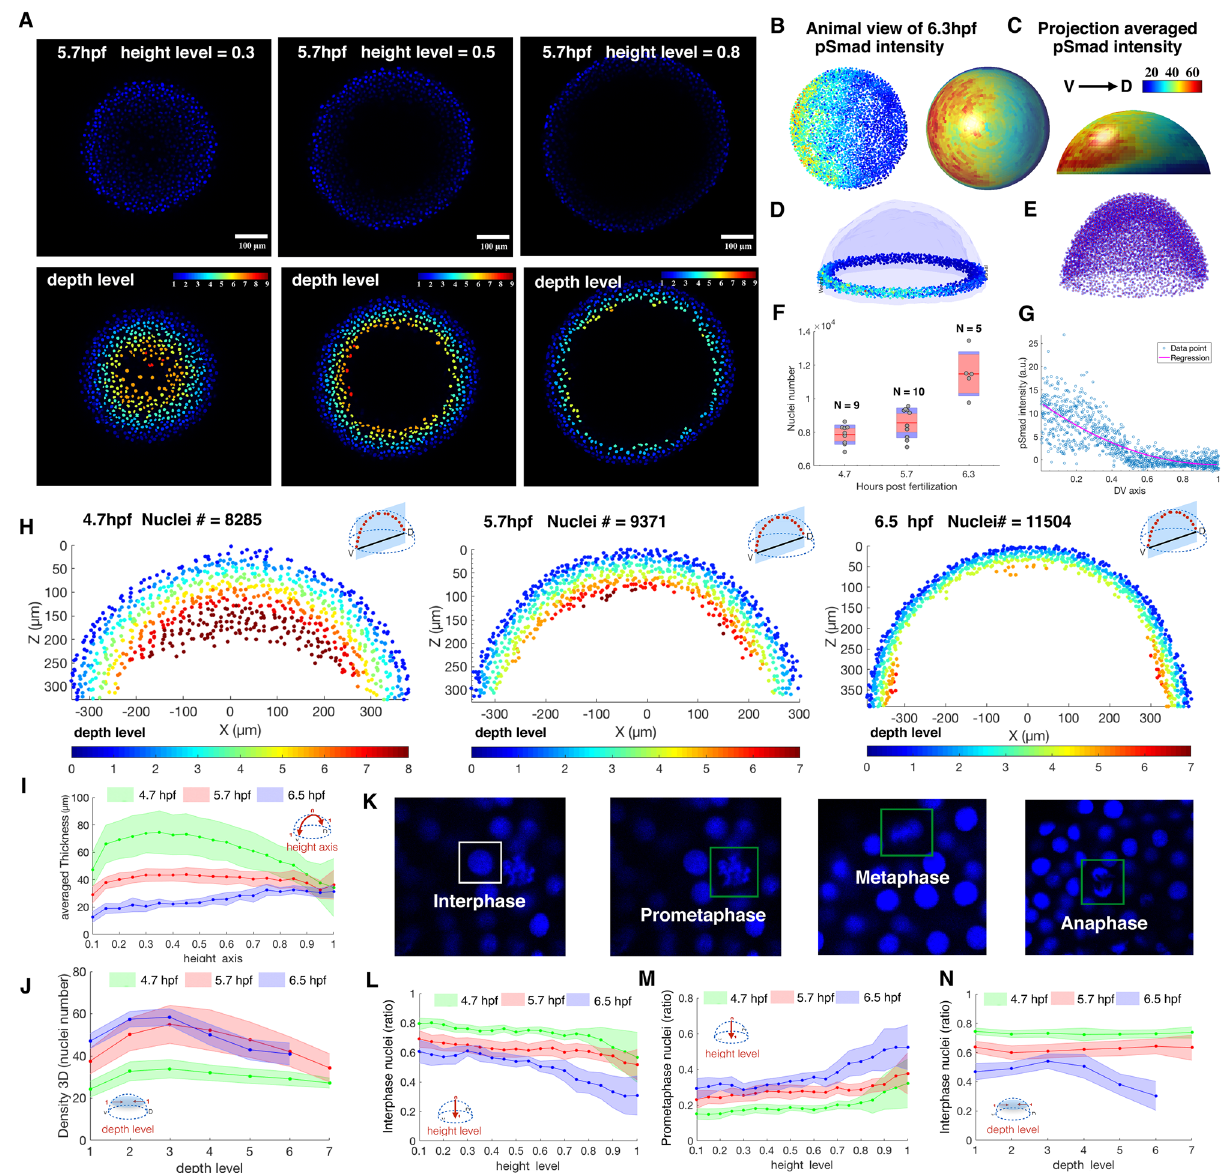
Figure 5. Example quantification of nuclear pSMAD gradient in Zebrafish embryo and spatial analysis of embryo coordinate system, 3D topology features and cell cycle phase patterns between 4.7, 5.7, 6.5 hpf Zebrafish embryo. ( A ) Z-slice DAPI nuclear stain (upper) and depth level for each nucleus on height level = 0.3, 0.5, 0.8 in 5.7 hpf Zebrafish embryo (lower). ( B , C ) Animal view of nuclear pSMAD intensity of all nuclei from the 6.3hpf embryo (left), and animal and lateral view of averaged pSMAD intensity by projecting to uniform distributed semisphere surface using WaveletSEG (center and right). ( D ) Data visualization of nuclear pSMAD intensity for 6.5 hpf Zebrafish embryo in marginal region using WaveletSEG. Light blue and dark blue transparent shells indicate inner and outer boundary surfaces of all nuclei in embryo. ( E ) Embryo alignment using coherent point drift (CPD) method in WaveletSEG. ( F ) Nuclei number counts of embryo vs different developmental time (4.7hpf: N = 9, 5.7hpf: N = 10, 6.5hpf: N = 5) which also applied in (i-j, l-n). Gray dots are individual embryo nuclei number. Red line red box region, and blue region show the mean nuclei number, 95% confidence region and region between one standard deviation. ( G ) Distribution of nuclear pSMAD intensity vs DV axis in embryo margin region in ( C ). Blue dot and red line indicate individual nuclei intensity and averaged intensity along DV axis. ( H ) Depth level spatial distribution for nuclei in DV direction cross section plane ± 30 um of 4.7 hpf (left), 5.7 hpf (center) and 6.5hpf Zebrafish embryo (right). ( I ) Averaged nuclear layer thickness through embryo height axis in 4.7, 5.7 and 6.5hpf embryo developmental time. ( J ) Averaged nuclear density through embryo height axis in 4.7, 5.7 and 6.5hpf embryo developmental time. Green, red and blue dark line indicate mean value, and light green, light red and light blue regions indicate one standard deviation region. ( K ) Examples of cell cycle phase in mitosis based on nuclei shape classification results. ( L ) Interphase nuclei count ratios through embryo height level in 4.7, 5.7 and 6.5 embryo developmental time. ( M ) Prometaphase nuclei count ratios through embryo height level in 4.7, 5.7 and 6.5 embryo developmental time. ( N ) Interphase nuclei count ratios through embryo depth level in 4.7, 5.7 and 6.5 embryo developmental time. ( L – N ) Green, red and blue dark lines indicate mean value, and light green, light red and light blue regions indicate one standard deviation